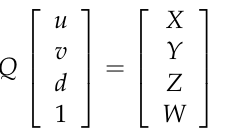
Figure 4. Binocular ranging principle [18]. The image coordinates ( u , v ) can be reprojected to the world coordinates (X, Y, Z) through the 4 × 4 reprojection matrix ( Q ) in order to obtain the actual 3D coordinates, which can be related according to Equation